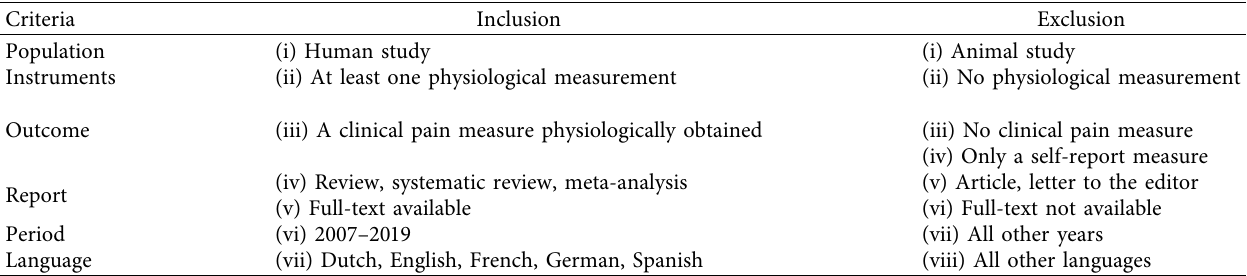
Table 1: Inclusion and exclusion criteria.